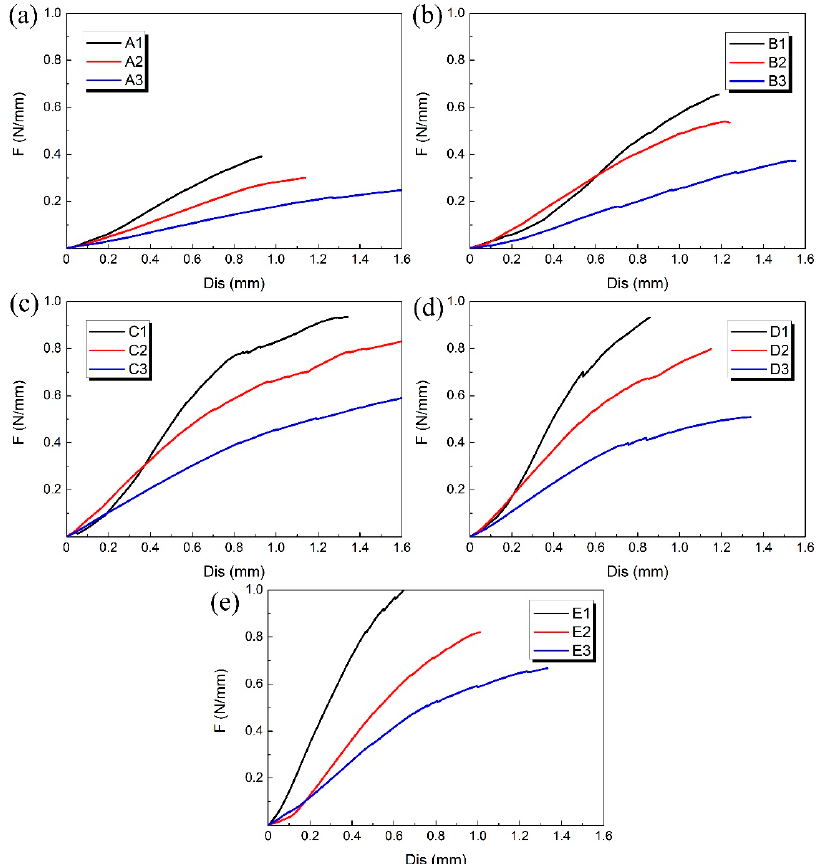
Figure 7. Radial force (per unit length) versus radial displacement curves for different groups of 3D-printed PLA vascular stents: from ( a – e ) are A, B, C, D and E group respectively.